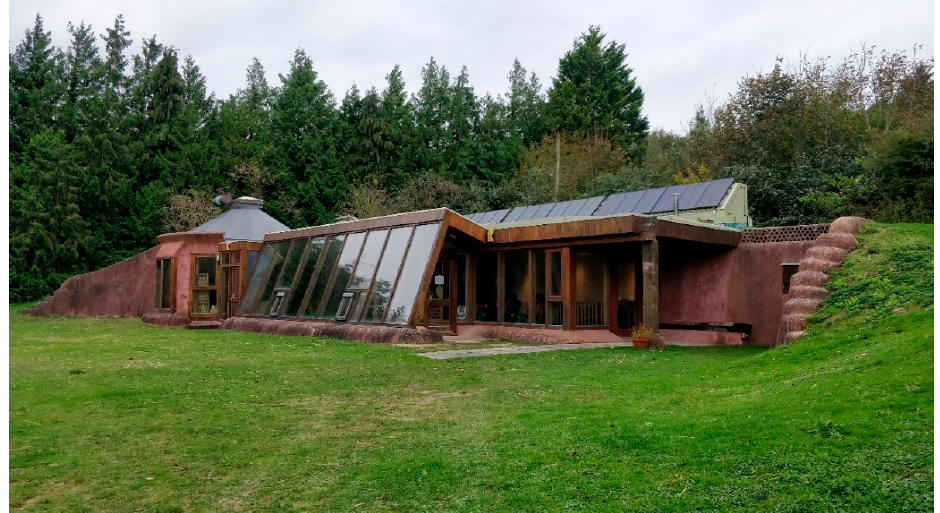
Figure 1. Photo of the Brighton Earthship (taken 03/11/2019) shows the south-facing glazing wall, angled for maximum solar gain, flanked by tire walls, and a roof that is topped with banks of photovoltaic solar panels.